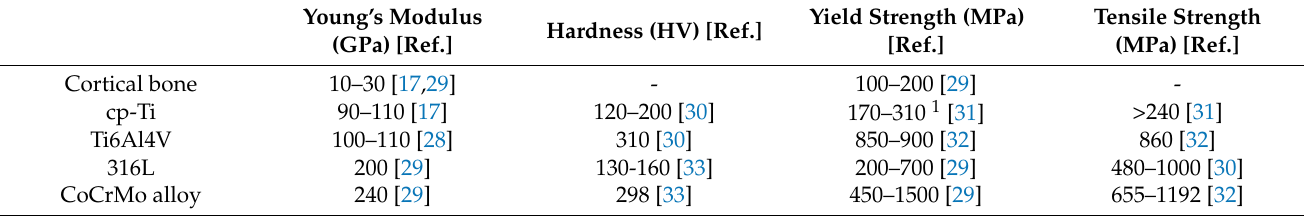
Table 1. Mechanical properties of cortical bone and conventional alloys. Young’s Modulus